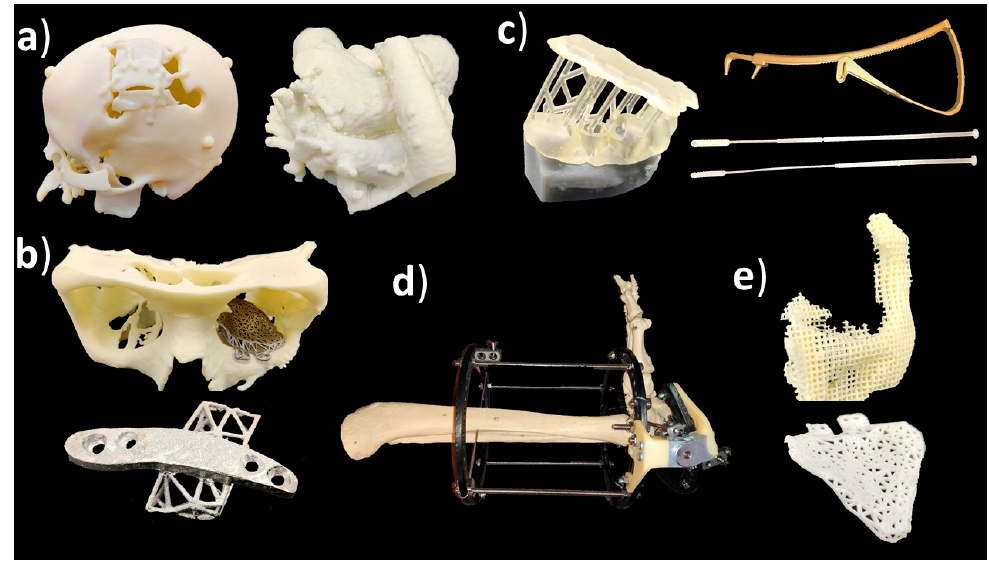
Figure 1. ( a ) Medical models; ( b ) implants; ( c ) tools, instruments and parts for medical devices; ( d ) medical aids, supportive guides, splints and prostheses; ( e ) biomanufacturing.